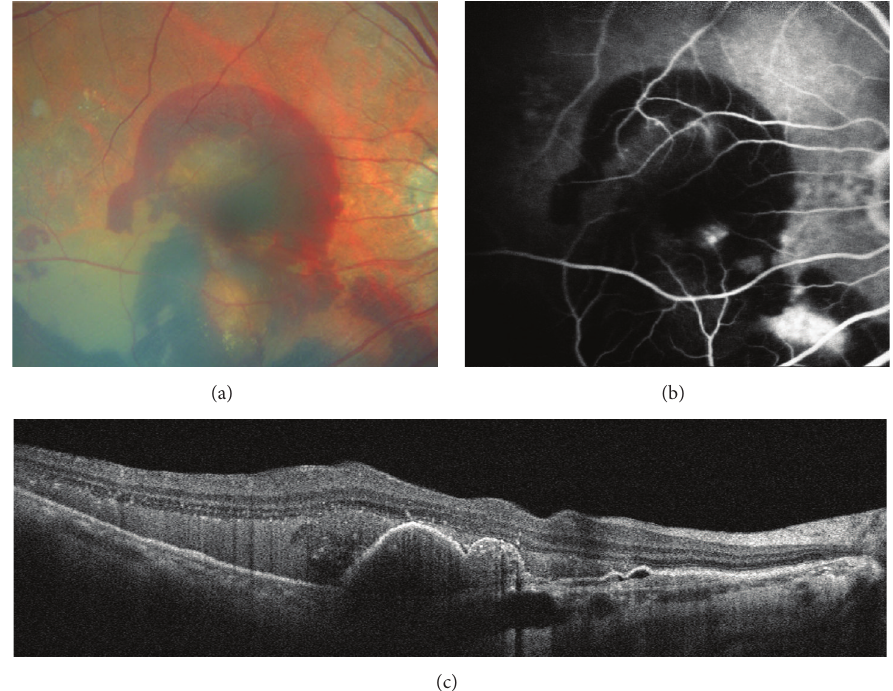
Figure 3: Images of subretinal hemorrhage observed in false-negative case on optical coherence tomography angiography (OCTA). (a) Color fundus photograph of the patient showing large amounts of subretinal hemorrhage. (b) Late-frame FA image displaying big leakage and pooling at the inferonasal to the macula together with posterior pole pigment epithelium detachment, also with masking effect attributable to subretinal hemorrhage. (c) Spectral-domain optical coherence tomography (SD-OCT) demonstrating large amounts of subretinal hemorrhage over the retinal pigment epithelial (RPE)